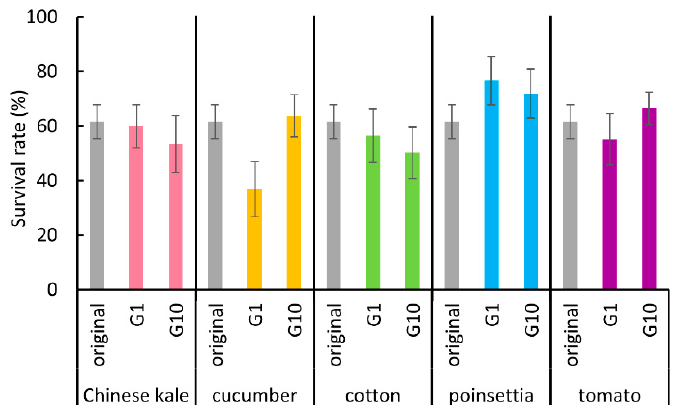
Figure 1. The survival rate of “egg and nymphal stages” of B. tabaci reared on each host plant in the first and tenth generations, and the original colony. Vertical bars indicate standard errors. There were no significant differences (Kruskal-Wallis test, p > 0.05).